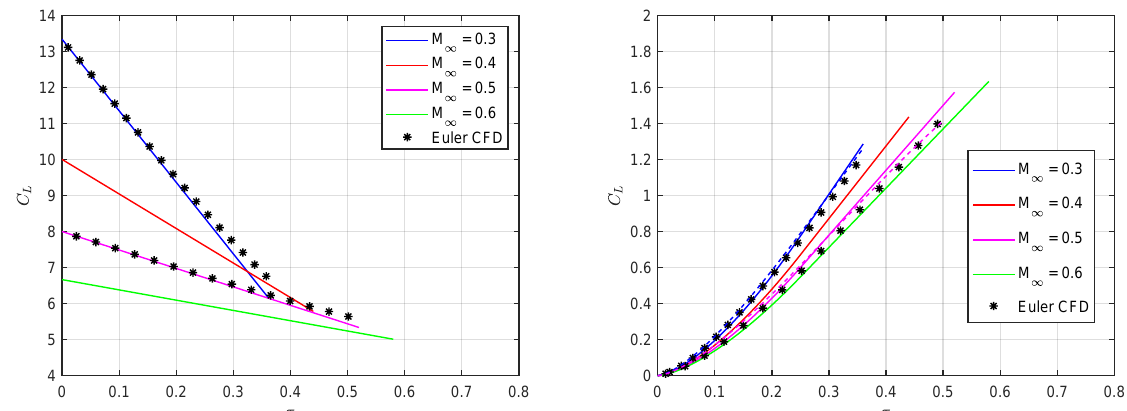
Figure 11. The incipient indicial lift for elliptical wing in compressible flow: AOA ( left ) and SEG ( right ), with η = 20.